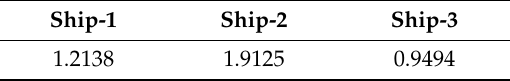
Figure 5. The ED distribution for S-RN signals.